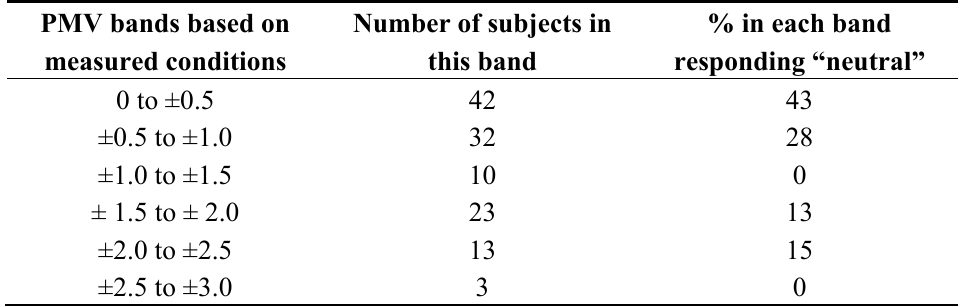
Table 3. Thermal sensation votes compared to PMV bands for the circulation zone study (adapted from [11]).